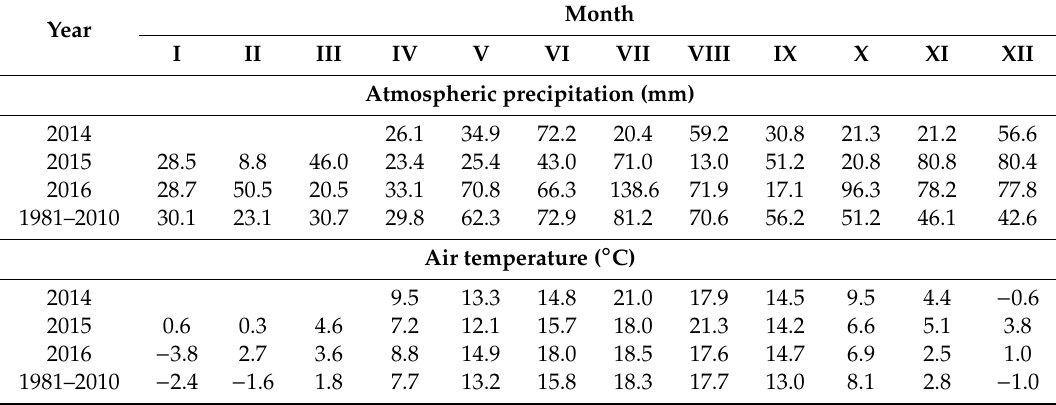
Table 5. Atmospheric precipitation and air temperature during the study period according to the Meteorological Station in